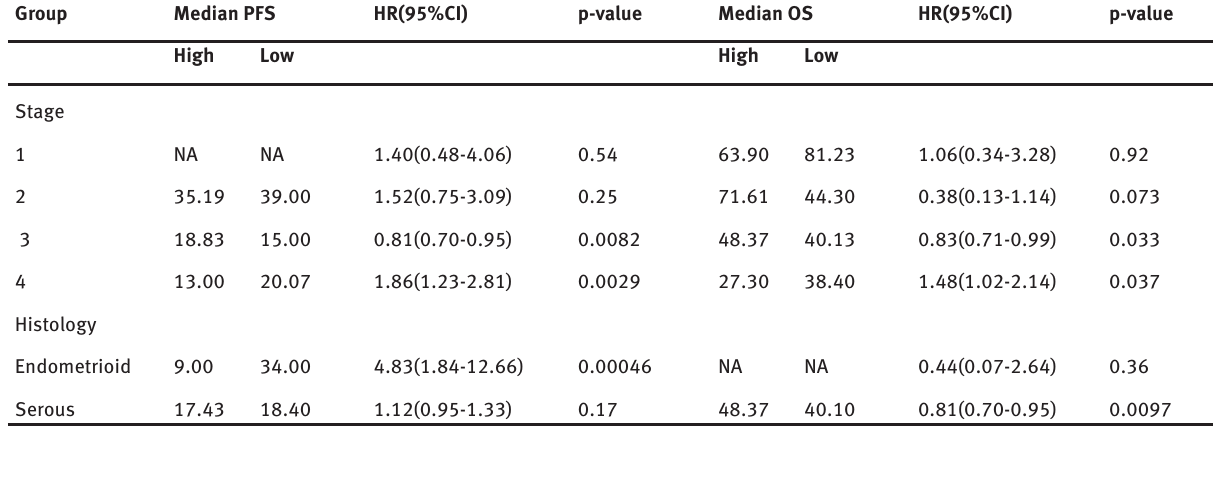
Table 2: Subgroup analysis of FOLR1 gene expression and patient prognosis according to stage and history. (NA = not applicable, HR = Hazard ratio, OS = overall survival, CI = confidence interval).